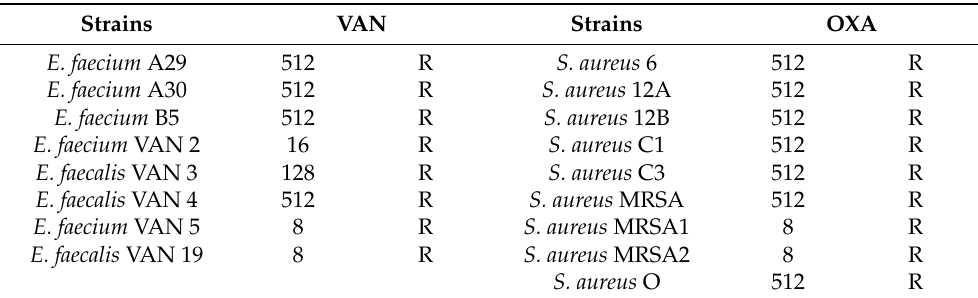
Table 1. Minimum inhibitory concentration (MIC) of vancomycin and oxacillin ( µ g/mL) against vancomycin-resistant enterococci (VRE) and methicillin-resistant Staphylococcus aureus (MRSA) strains, respectively. Abbreviations for antibiotics: VAN, vancomycin; OXA, oxacillin. Abbrevi- ations for interpretations: S = sensitive; I = intermediate; R = Resistant.